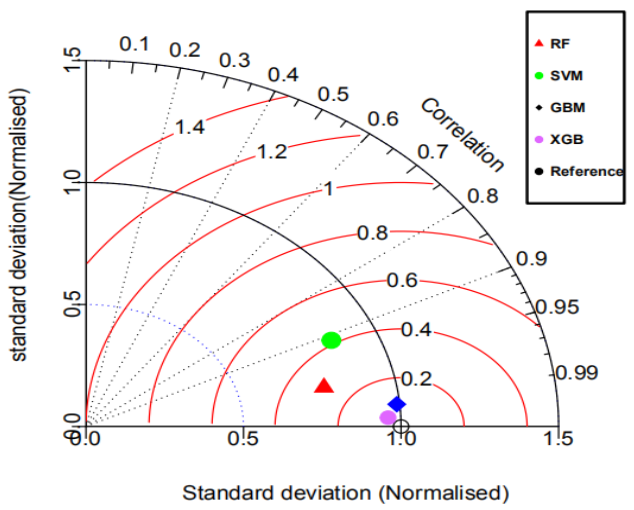
Figure 13. Taylor’s plot for ML model training datasets.